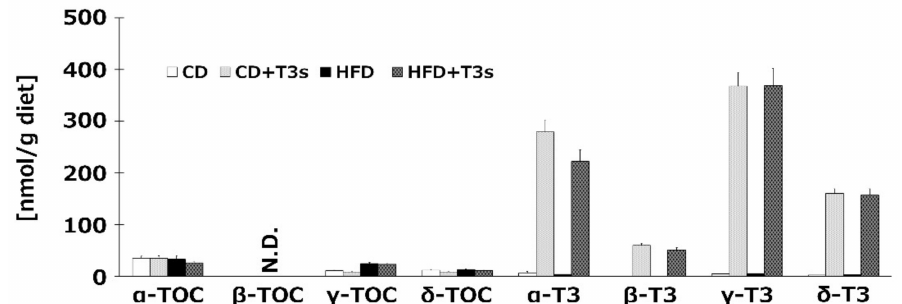
Figure 1. Vitamin E (VE) contents in each diet. VE isoforms in each diet were measured by HPLC-ECD. CD = Control diet ( n = 4), CD + T3s = CD + tocotrienols (T3) mix ( n = 4), HFD = high-fat diet ( n = 4), HFD + T3s = HFD + T3 mix ( n = 4). Data are expressed as mean ±